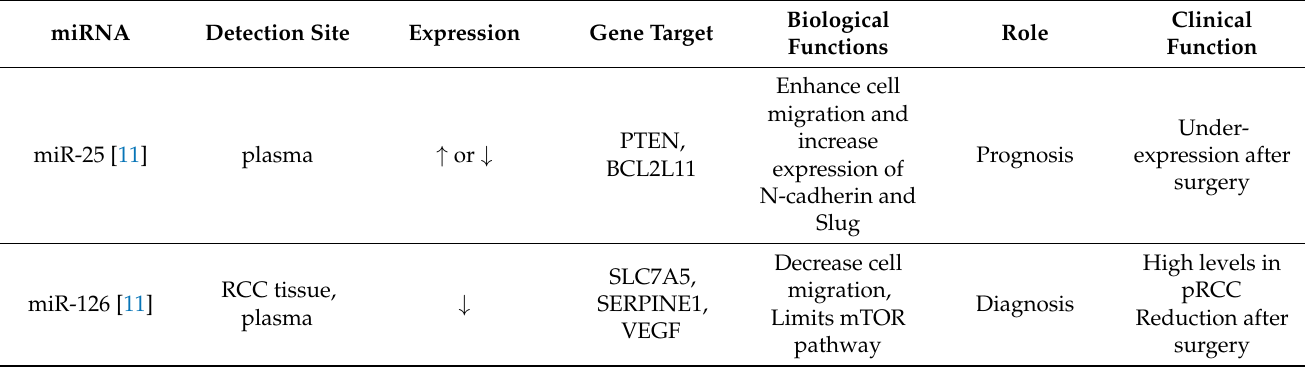
Table 1. The expression of mi-RNA in renal cell cancer. RCC: renal cell carcinoma; TKI: tyrosine kinase inhibitors. cc: clear cell; p: papillary; ch: